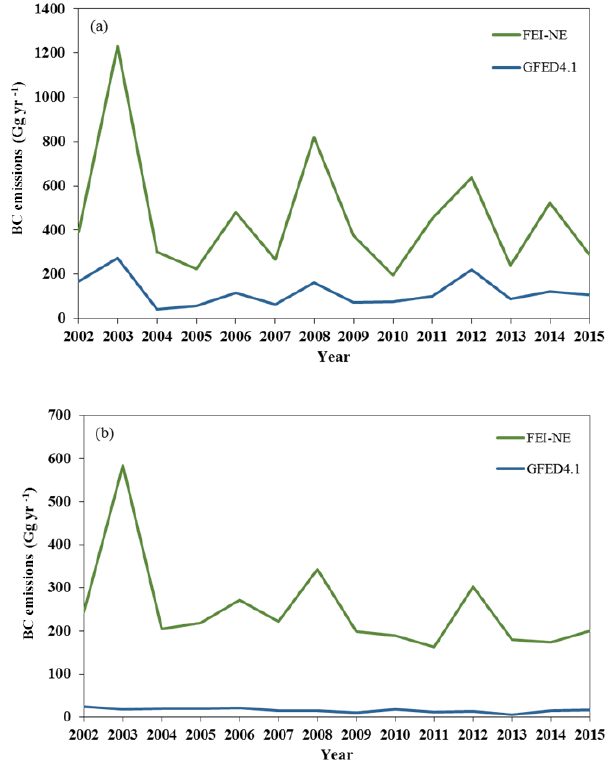
Figure 10. Comparisons of annual BC emissions from (a) for- est and (b) non-forest fires in northern Eurasia for FEI-NE and GFED4.1 from 2002 to